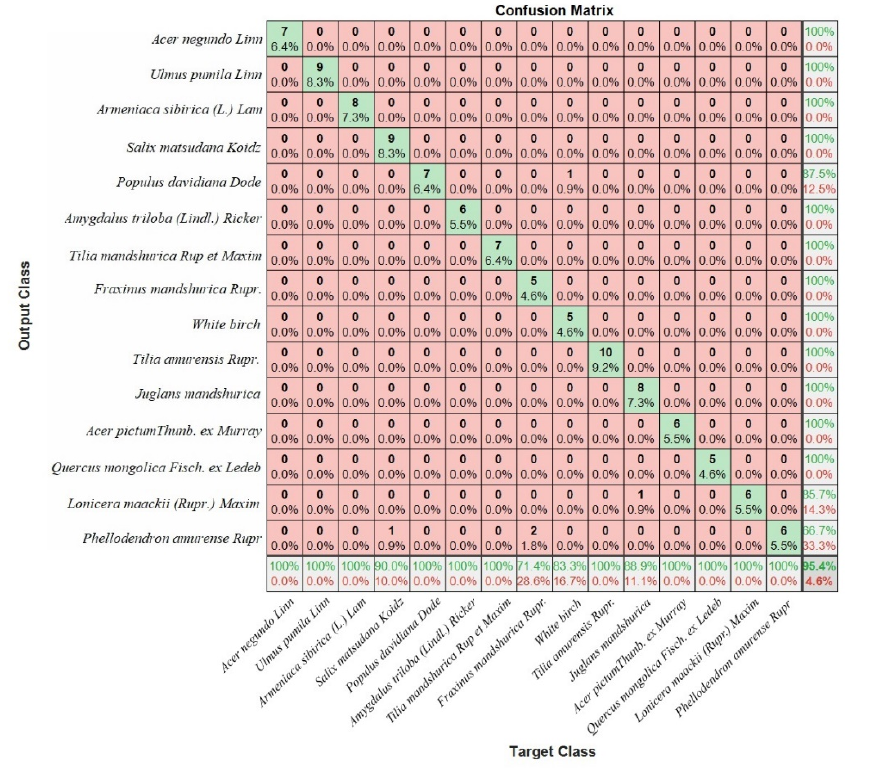
Figure 15. The confusion matrix of leaf small datasets by using VGG-16.